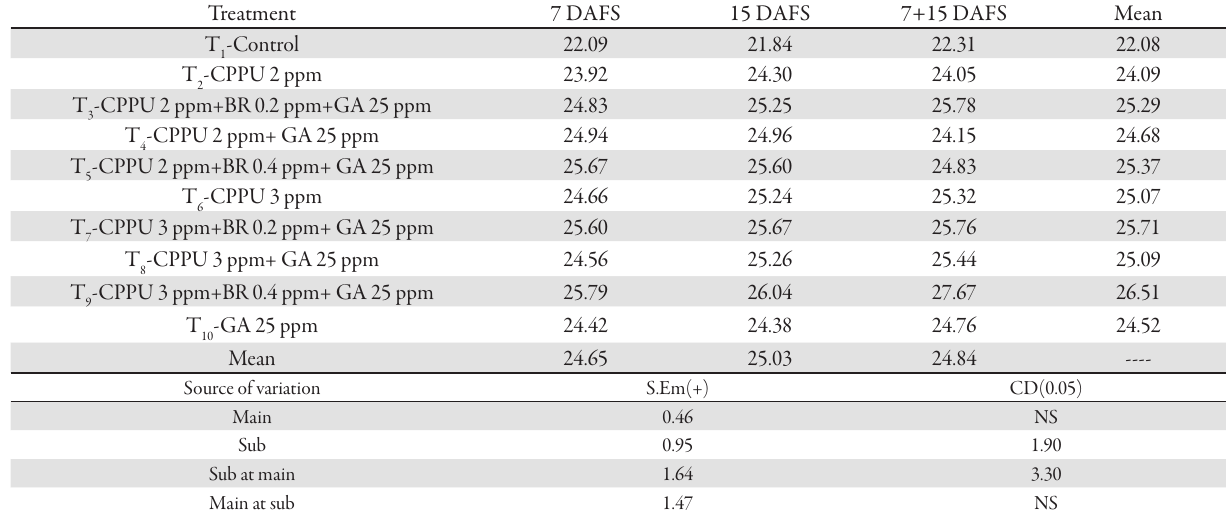
Tab. 3. Effect of growth regulators at different days after fruit set (DAFS) on leaf dry matter content (%) in grape Cv. ‘Tas-A- Ganesh’